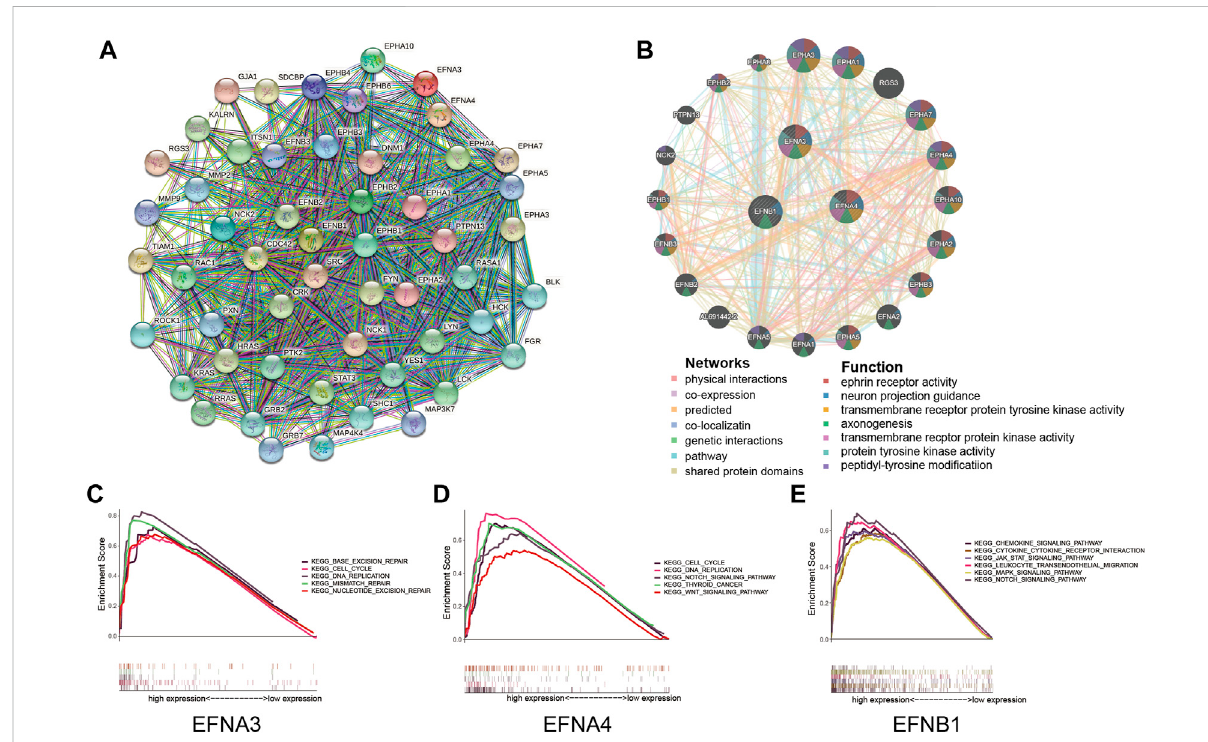
FIGURE 5 Protein interactions and gene set enrichment analysis (GSEA) of prognosis-related ephrin members (EFNA3, EFNA4, and EFNB1). (A) Protein – protein interactions (PPIs) based on the STRING database. (B) Interaction network for ephrin members based on the GeneMANIA database. (C – E) Gene set enrichment analysis (GSEA) of prognosis-related ephrin members, including EFNA3 (C) , EFNA4 (D) , and EFNB1 (E)